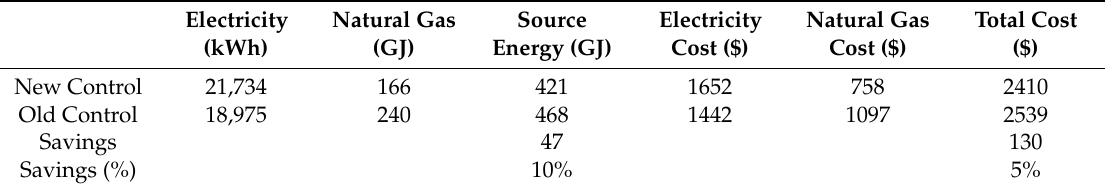
Table 2. Source energy and energy cost savings resulting from the new